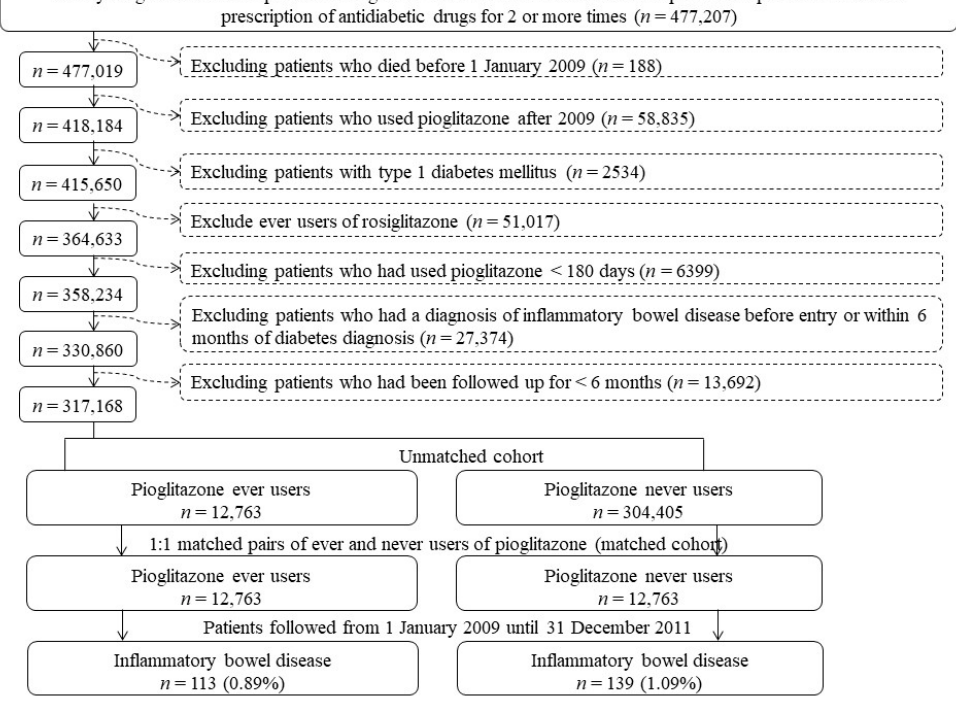
Figure 1. Flowchart showing the stepwise procedures followed in the enrollment of propensity score-matched pairs of pioglitazone ever users and never users.